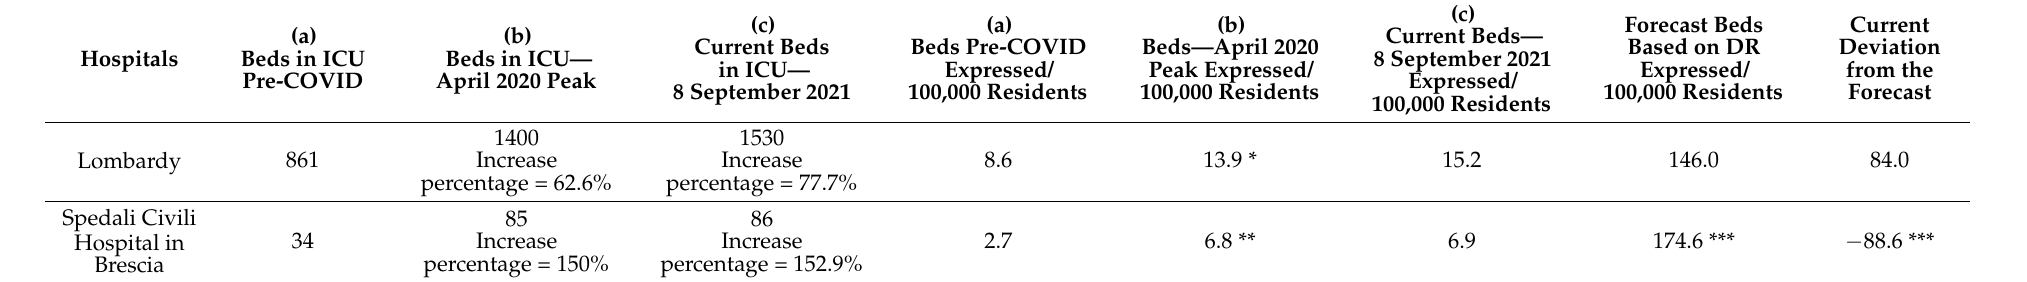
Table 14. Intensive care beds in relation to the acquisitions made and in